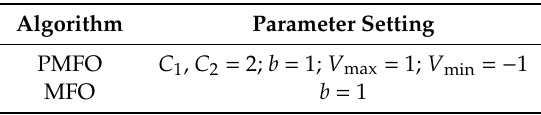
Table 4. Parameter setting of the validated Table 5. Unimodal test functions.